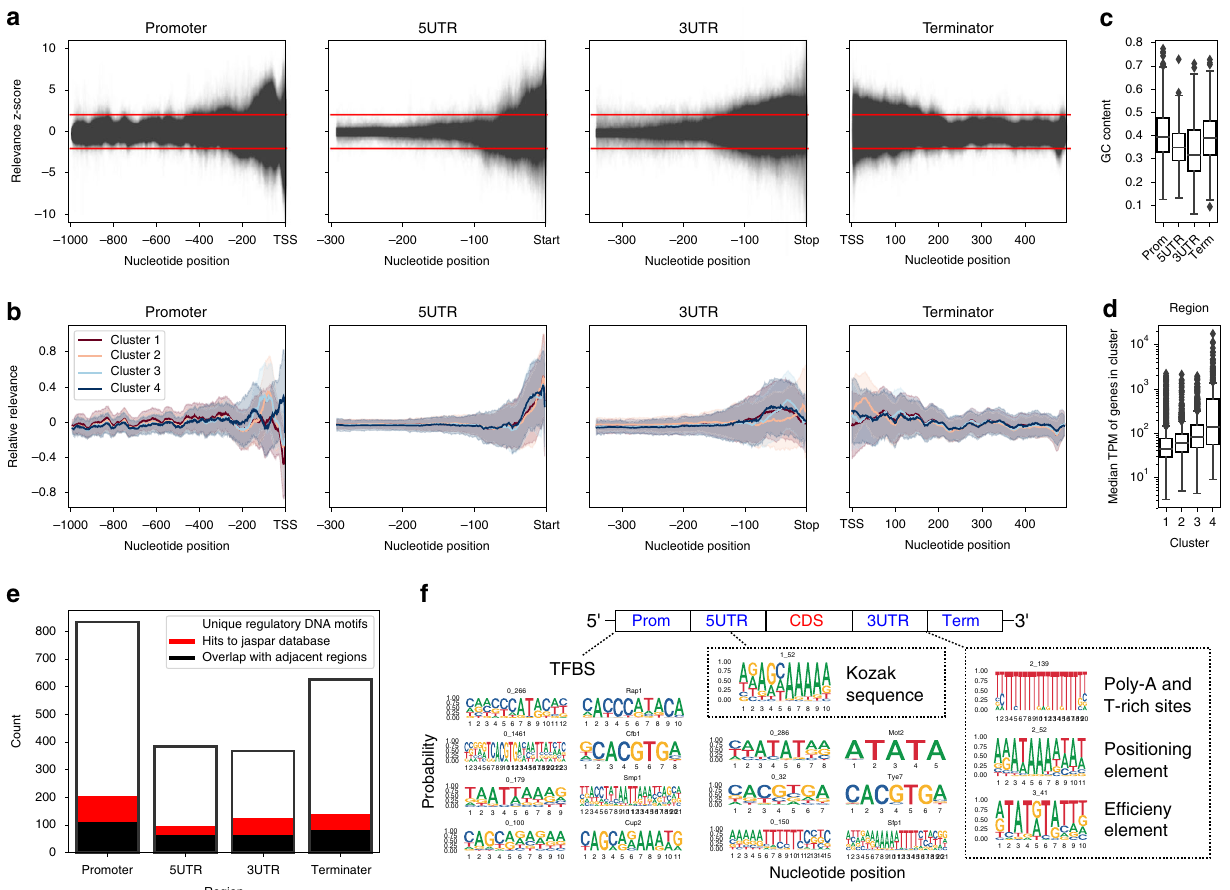
Fig. 3 Deep learning identi fi es the DNA positions predictive of expression levels. a Relevance pro fi les across cis -regulatory region sequences obtained by querying the deep models (Fig. 1f). Red lines denote cutoff of 2 standard deviations. The decrease in relevance of UTR sequences at left edges was due to the considerable number of sequences that were shorter than the analysed regions (see Fig. 1d). b Clustered relevance pro fi les across the cis -regulatory region sequences. The clusters 1 through 4 are colored dark red, light red, light blue and dark blue, respectively. Lines and shaded regions represent means and standard deviations, respectively. c GC content in the cis -regulatory regions ( n = 368, 383, 834 and 625, respectively). d Median expression levels of genes in the clustered relevance pro fi les ( n = 1385, 1187, 1206 and 460 with increasing cluster size, respectively). e Total amount of regulatory DNA motifs uncovered in the cis -regulatory regions, with the proportional amounts of motif overlap between adjacent regions (black) as well as with the Jaspar database 68 (red) highlighted. f Examples of regulatory DNA motifs uncovered across all the cis -regulatory regions that correspond to published motifs and sequence elements (see Supplementary Fig. 1c). “ TFBS ” denotes transcription factor binding sites. For box plots in c , d , boxes denote interquartile (IQR) ranges, centres mark medians and whiskers extend to 1.5 IQR from the quartiles. Source data are provided as a Source data fi